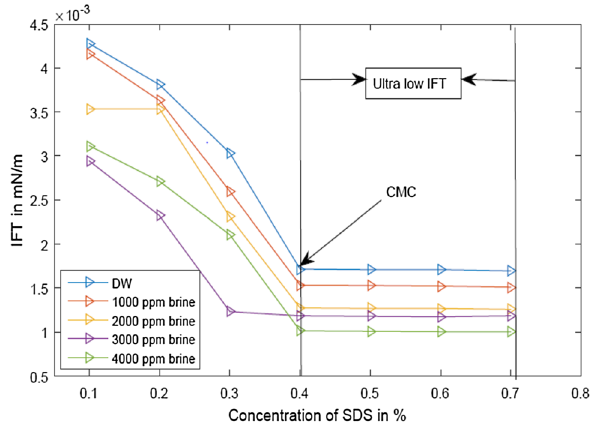
Fig. 5 IFT between NH crude and